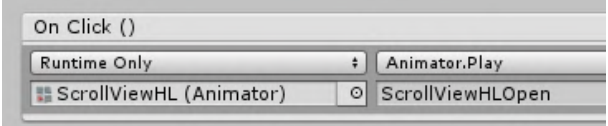
Figure 8: Setting the displaying button for the ScrollViewHL